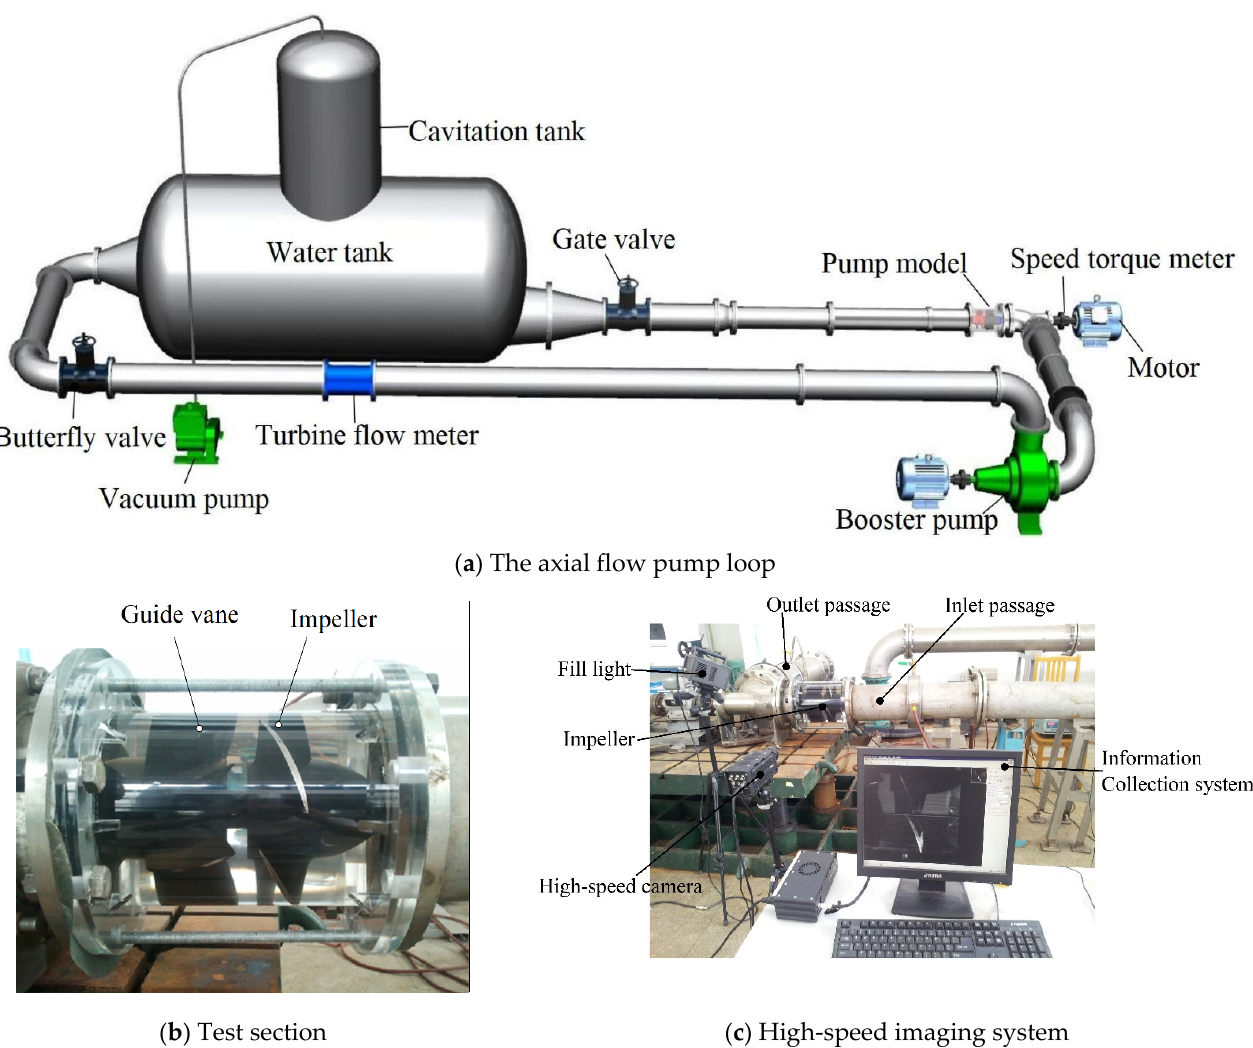
Figure 3. Experimental equipment used the axial flow pump to examine the external characteristics and cavitation.